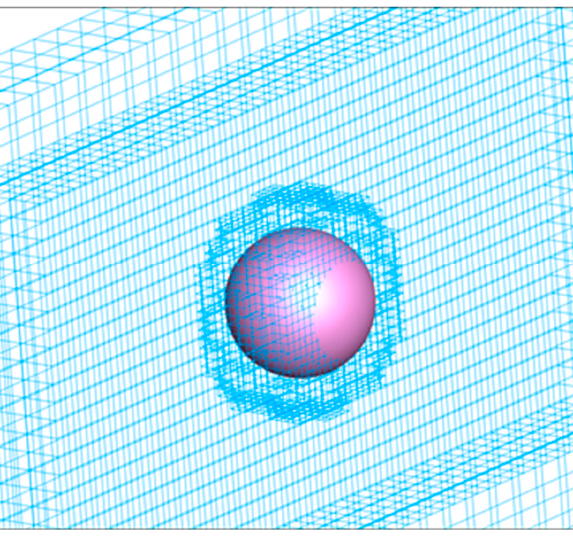
Figure 21. Schematic diagram of the computational domain of a flow past a sphere in 3D case.